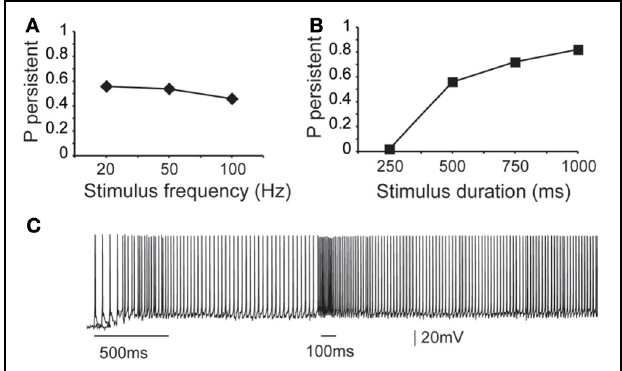
FIGURE 3 | Dependence of microcircuit spiking activity on stimulus-specific parameters. (A) Graph showing the effect of stimulus frequency (20, 50, 100Hz) on the probability of persistent activity initiation. Parameters used: iNMDA-to-iAMPA ratio = 2.3, iGABA B -to-iGABA A ratio = 0.4, dADP deactivated. (B) Graph showing the effect of stimulus Duration (250ms, 500ms, 750ms, 1s) on the probability of persistent activity initiation. Parameters used: iNMDA-to-iAMPA ratio = 2.3, iGABA B -to-iGABA A ratio = 0.4, dADP deactivated. (C) Indicative voltage trace showing the effect of a second excitatory stimulus (100Hz, 10 events) to the pyramidal neurons. Bars indicate stimulus presentation